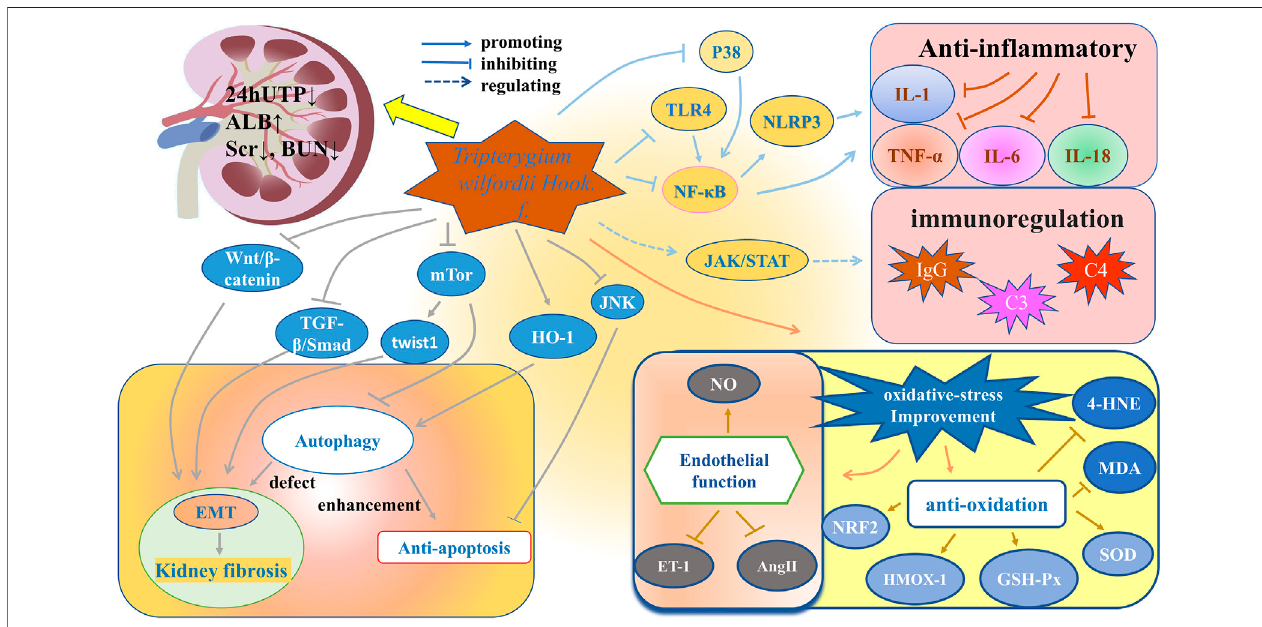
FIGURE 4 | Targets and signaling pathways of TwHF and its preparations in treating